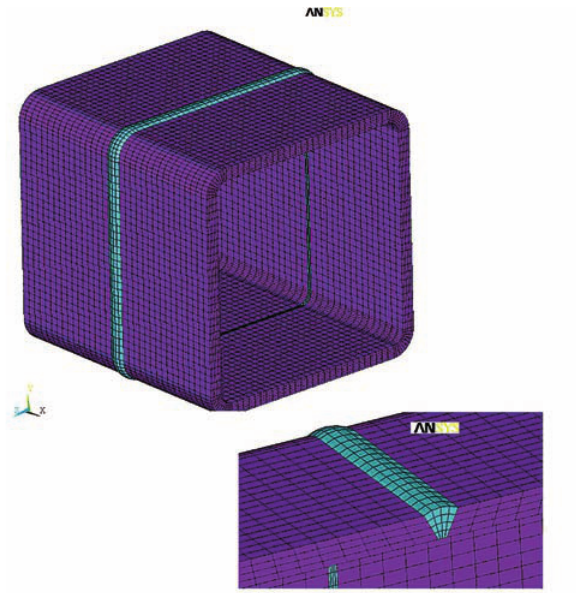
Fig. 1. FE model of welded